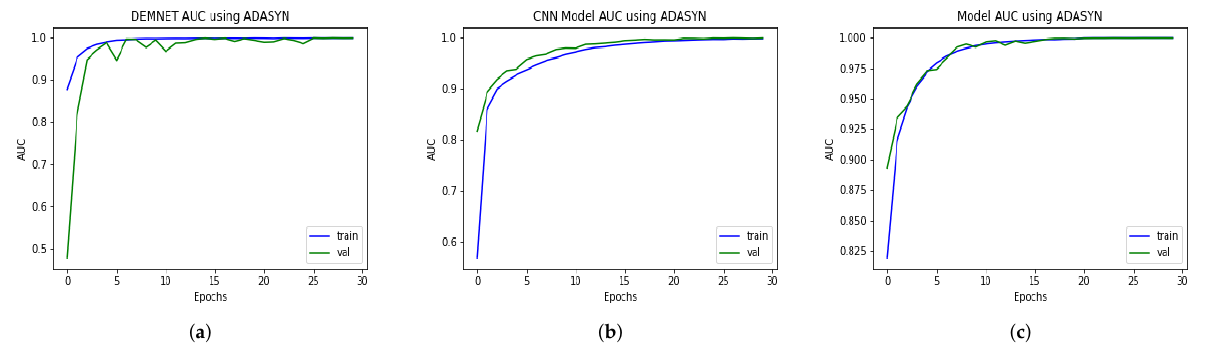
Figure 18. AUC Comparison of DEMNET, CNN Model, and DAD-Net using ADASYN. ( a ) DEMNET; ( b ) CNN Model; ( c ) Proposed DAD-Net.